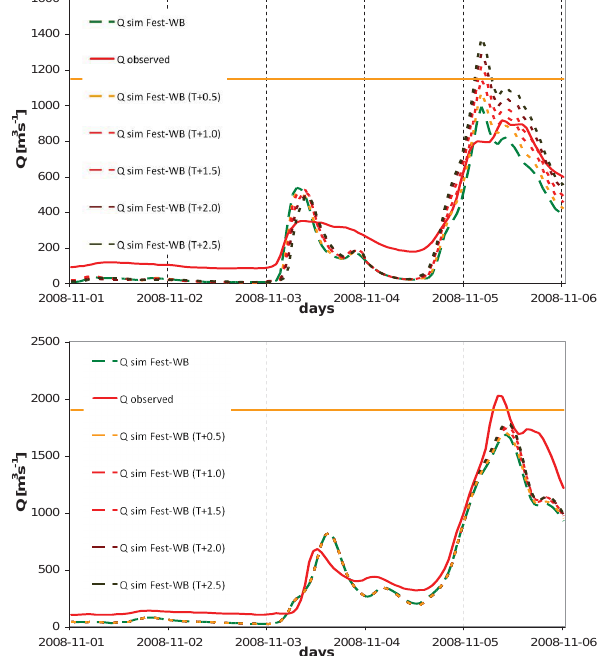
Fig. 10. Discharge simulations over the Toce (above) and Sesia (be- low) basins, with the modified temperature field as input into the FEST-WB model initialized on the 1 November 2008. The mea- sured discharges at Candoglia and Palestro are highlighted in red, the FEST-WB simulations forced with observed data are shown by the green lines, while coloured dashed lines refer to discharge simulation by the FEST-WB model forced with increased tempera- ture at 0.5 ◦ C intervals. In this case we launched the simulation on 1 November to show the entire simulation for the event. The horizontal orange line is warning code 2 for the Toce (above) and Sesia (below) basins.